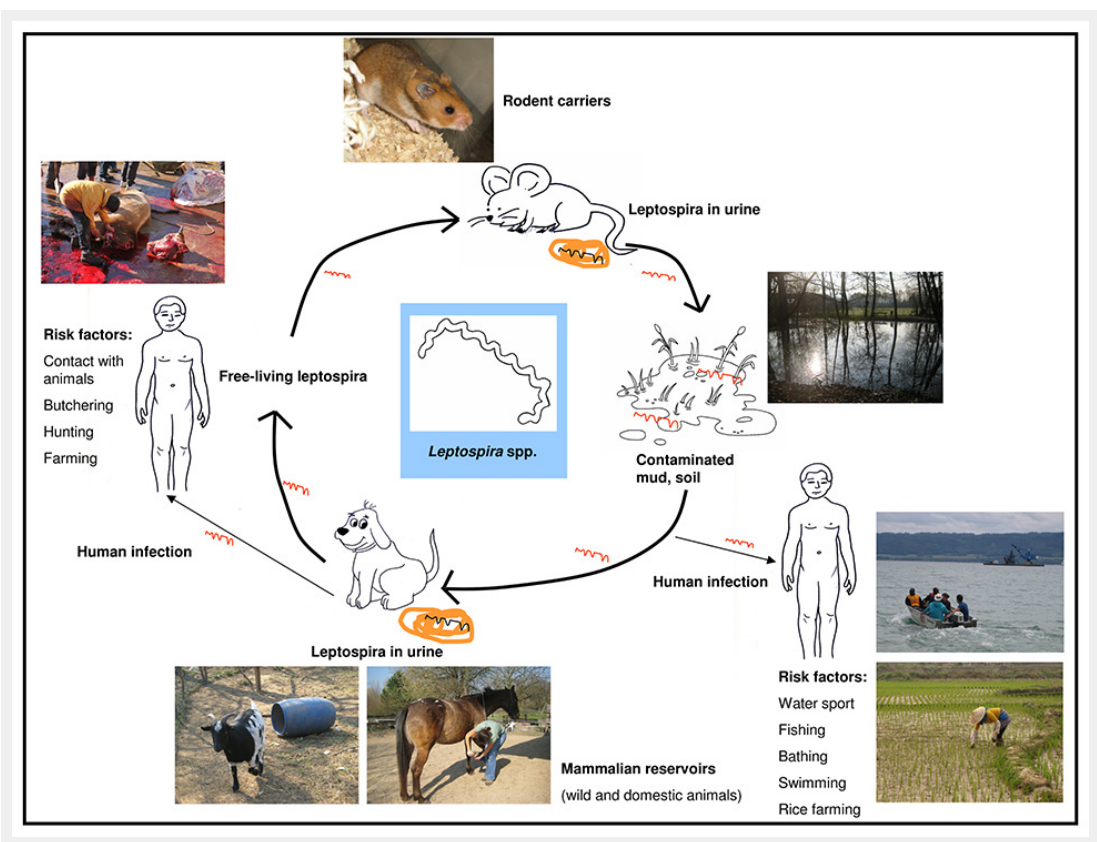
Figure 2 Life cycle of pathogenic Leptospira spp., the infectious agents of